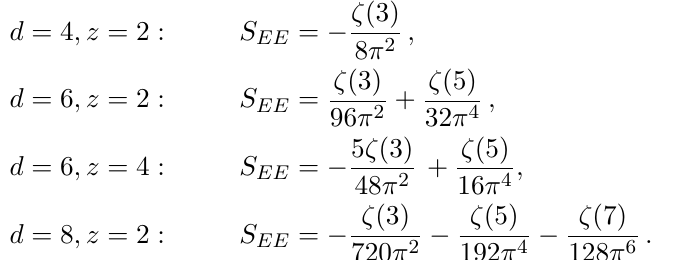
p g , which c p g of the target space, which c